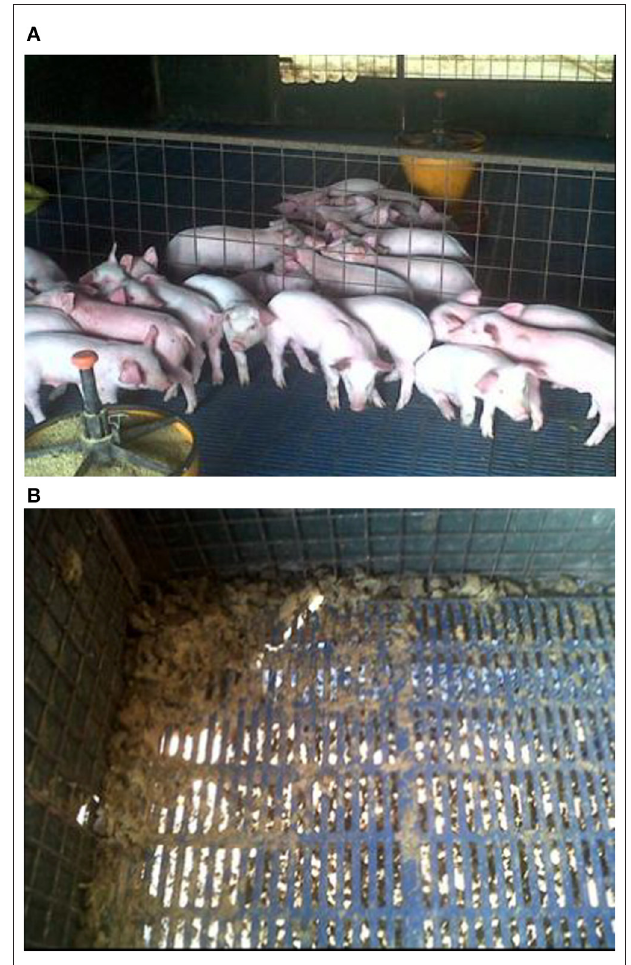
FIGURE 3 | Visual representation of colibacillosis clinical signs and associated diarrhea in Experiment 3. (A) Piglets in the ESV vaccinated group displayed normal behavior and were absent of clinical signs (bottom) while piglets in the Control group huddled together and were lethargic (top). (B) Widespread colibacillosis was present in the Control group.